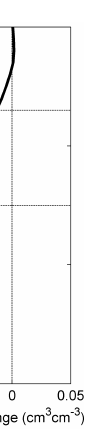
Fig. 14. SWC change for the whole soil profile between the first day of ERT measurement (13 August 2009) and the last day (18 Septem- ber 2009). Negatives values mean a decrease of SWC during the experimental time and positives values an increase of SWC. The vertical dotted line is the limit between increase and decrease of SWC. The horizontal dotted lines correspond to the limits of the soil